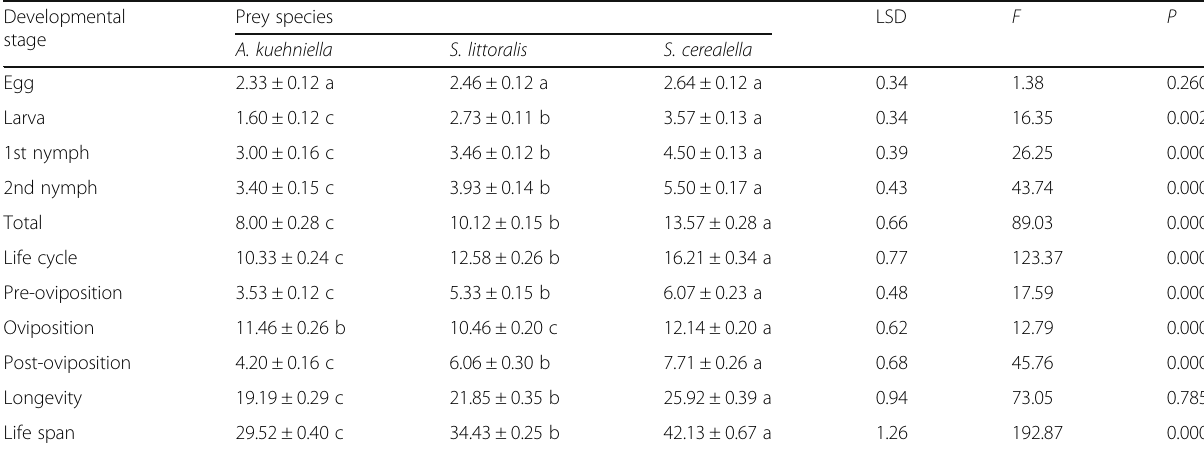
Table 4 Duration (in days) of Neosiulus barkeri females fed eggs of Anagasta kuehniella , Spodoptera littoralis , and Sitotroga cerealella and incubated at 27 °C and 70% RH Developmental